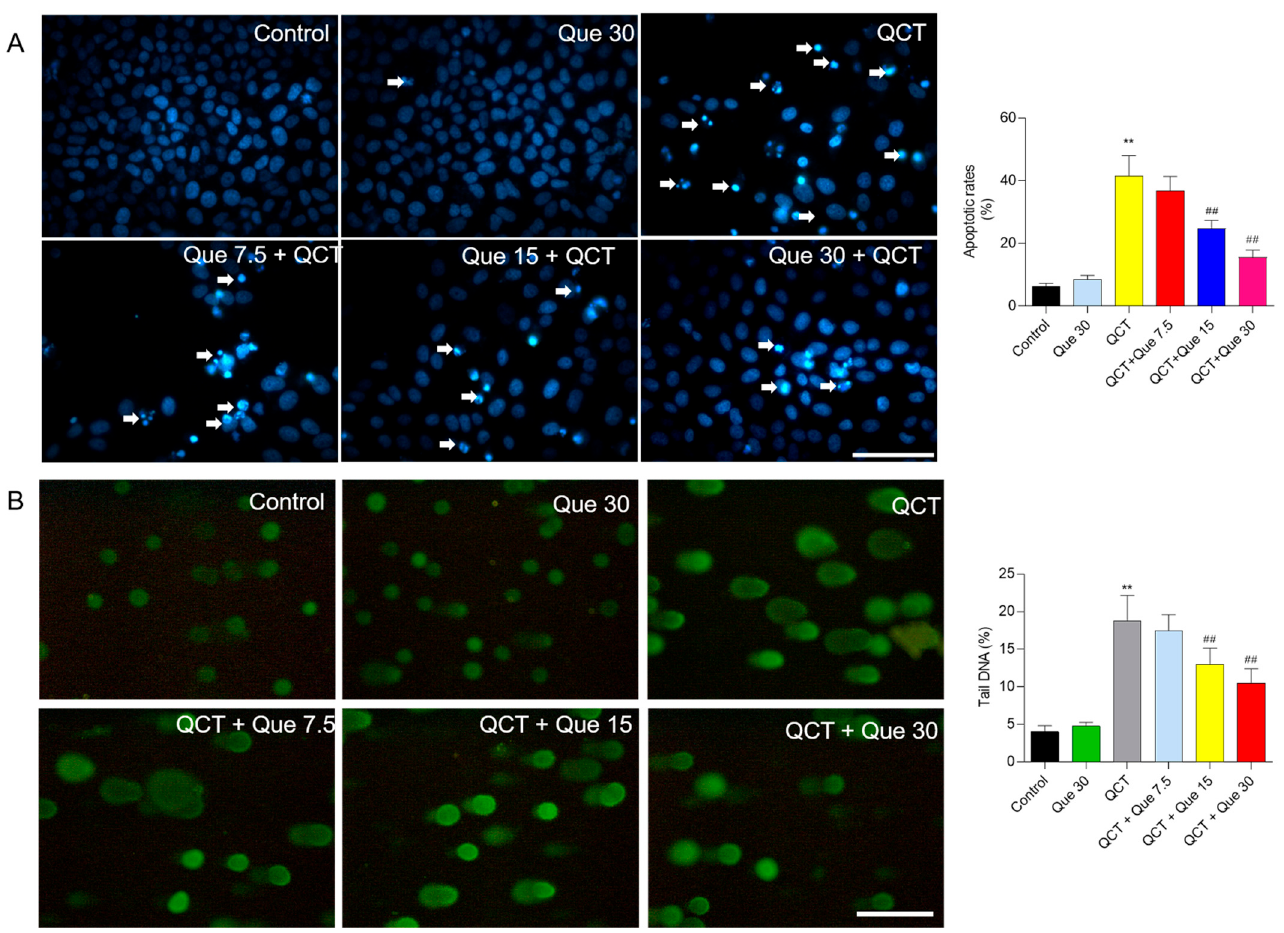
Figure 3. The effect of quercetin supplementation on QCT-induced cell apoptosis and DNA damage in human L02 cells. ( A ), the representative images of cell apoptosis and the results of quantitative analysis. L02 cells were treated with quercetin pretreatment at concentrations of 7.5, 15, and 30 μ M for 2 h, followed by co ‐ treatment with QCT at a final concentration of 5 μ g/mL for an additional 24 h, and cell apoptosis was stained with Hoechst 33342. Finally, the representative images were obtained using the fluorescence microscope (on the left) and apoptotic rates were quantified using Image J (on the right). The white arrowheads indicate the apoptotic cells. ( B ), the results of the comet assay. L02 cells were pretreated with quercetin at final concentrations of 7.5, 15, and 30 μ M for 2 h, followed by co ‐ treatment with QCT at a final concentration of 5 μ g/mL for 4 h, and the comet assay was performed. The representative images were obtained using the fluorescence microscope (on the left) and the percentage (%) of tail DNA was quantified (on the right). All results were presented as mean ± SD ( n = 4 independent experiments). ** p < 0.01, compared to the vehicle control group; ## p < 0.01, compared to the QCT ‐ alone group. QCT, quinocetone; Que, quercetin; Bar = 50 μ m.